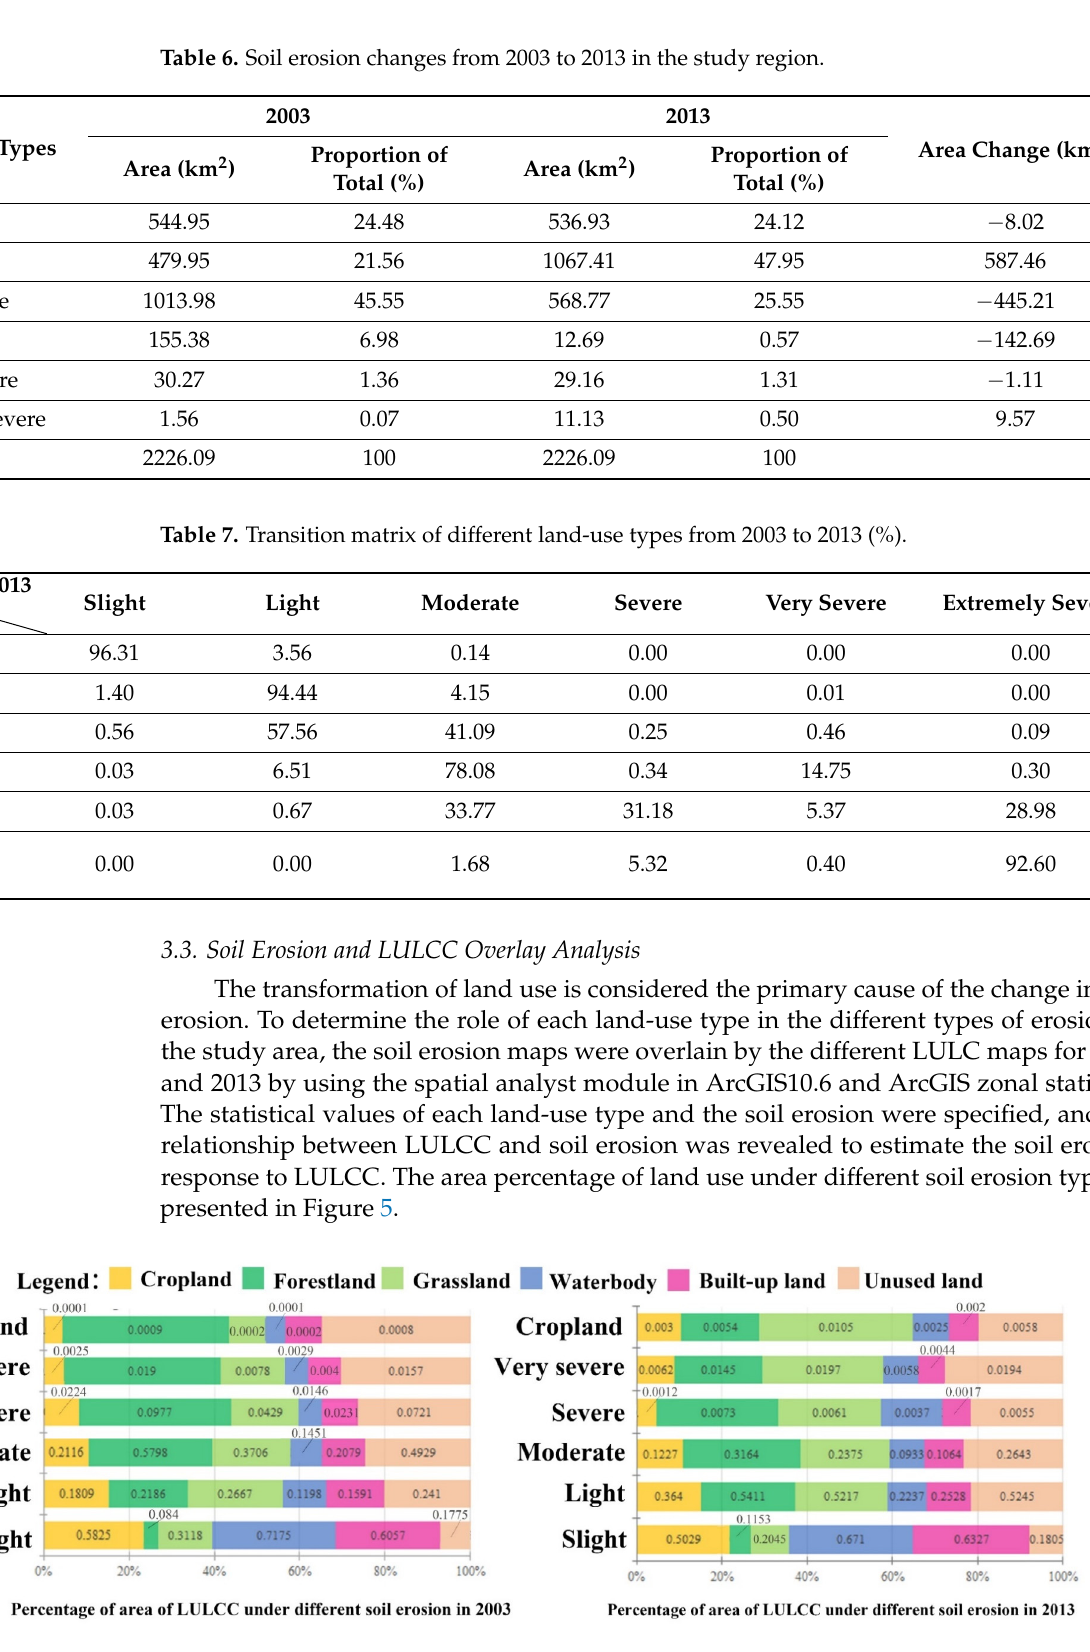
Figure 5. Overlay analysis map of land-use change and soil erosion for 2003 and 2013. A slight soil erosion level was found for water bodies (approximately 71.75% and 67.10% in 2003 and 2013, respectively), followed by built-up land and cropland. However, cropland and forest occupied the largest areas of 120.31 km 2 in 2003 and 151.89 km 2 in 2013. Water bodies and grassland covered the smallest areas, accounting for 72.45 km 2 in 2003 and 24.58 km 2 in 2013.